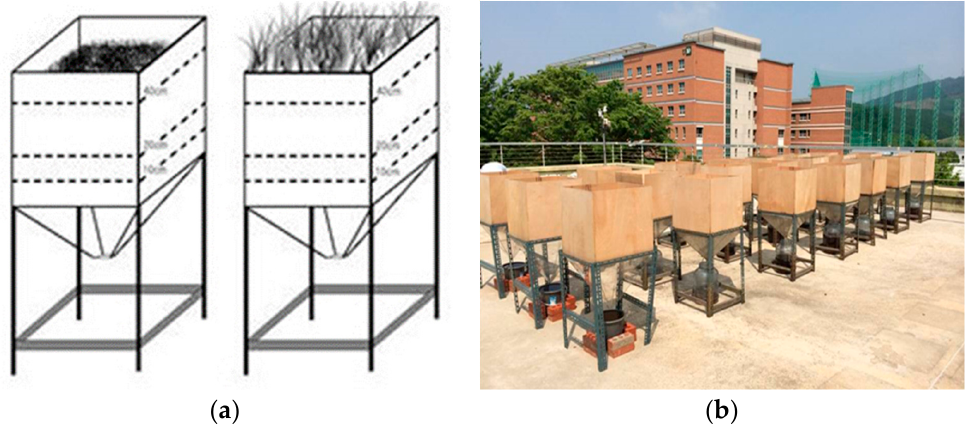
Figure 1. ( a ) Sketch of the structure of platforms, and ( b ) photo of the field experiment of runoff plots of green roofs.